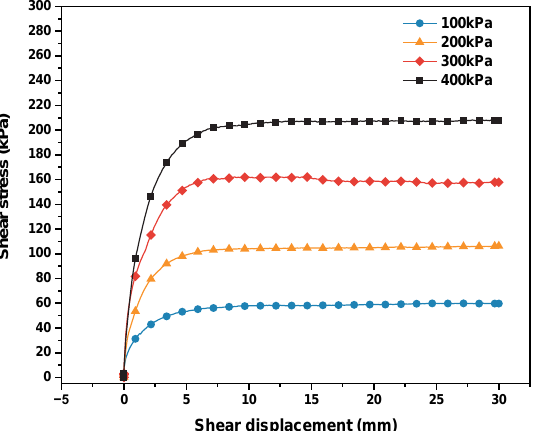
Figure 9. The relationships between the shear stress and shear displacement of the interfaces under different vertical stresses.